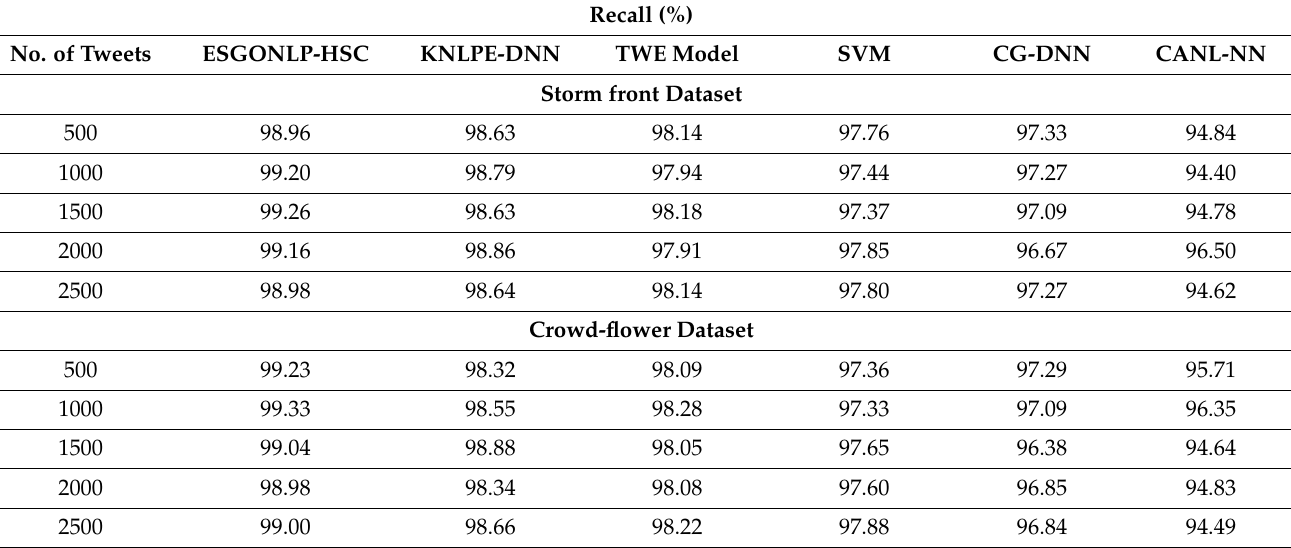
Figure 8 examines the comparative reca l results of the ESGONLP-HSC system